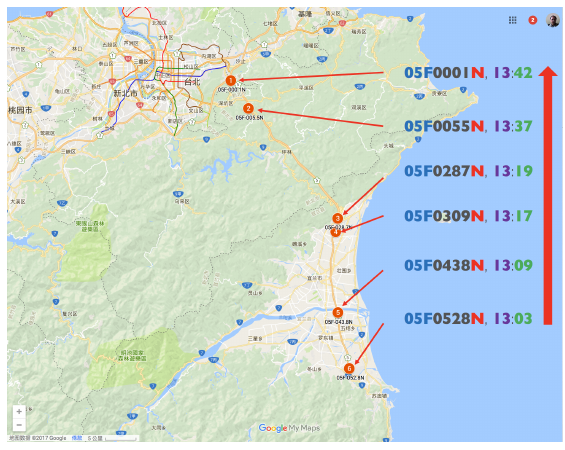
Figure 8. Example: one travel time pattern in northern (N) direction from “05F0528N” to “05F0001N” (Travel Time = 39